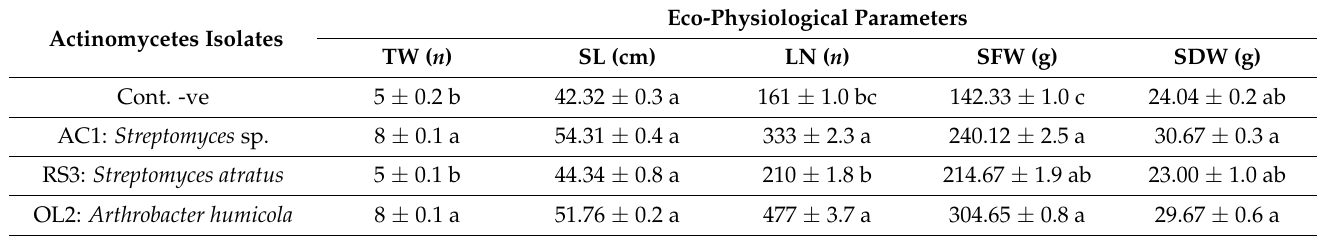
Table 4. Effect of Actinomycetes isolates on eco-physiological parameters of tomatoes (artificially infected with S. sclerotiorum